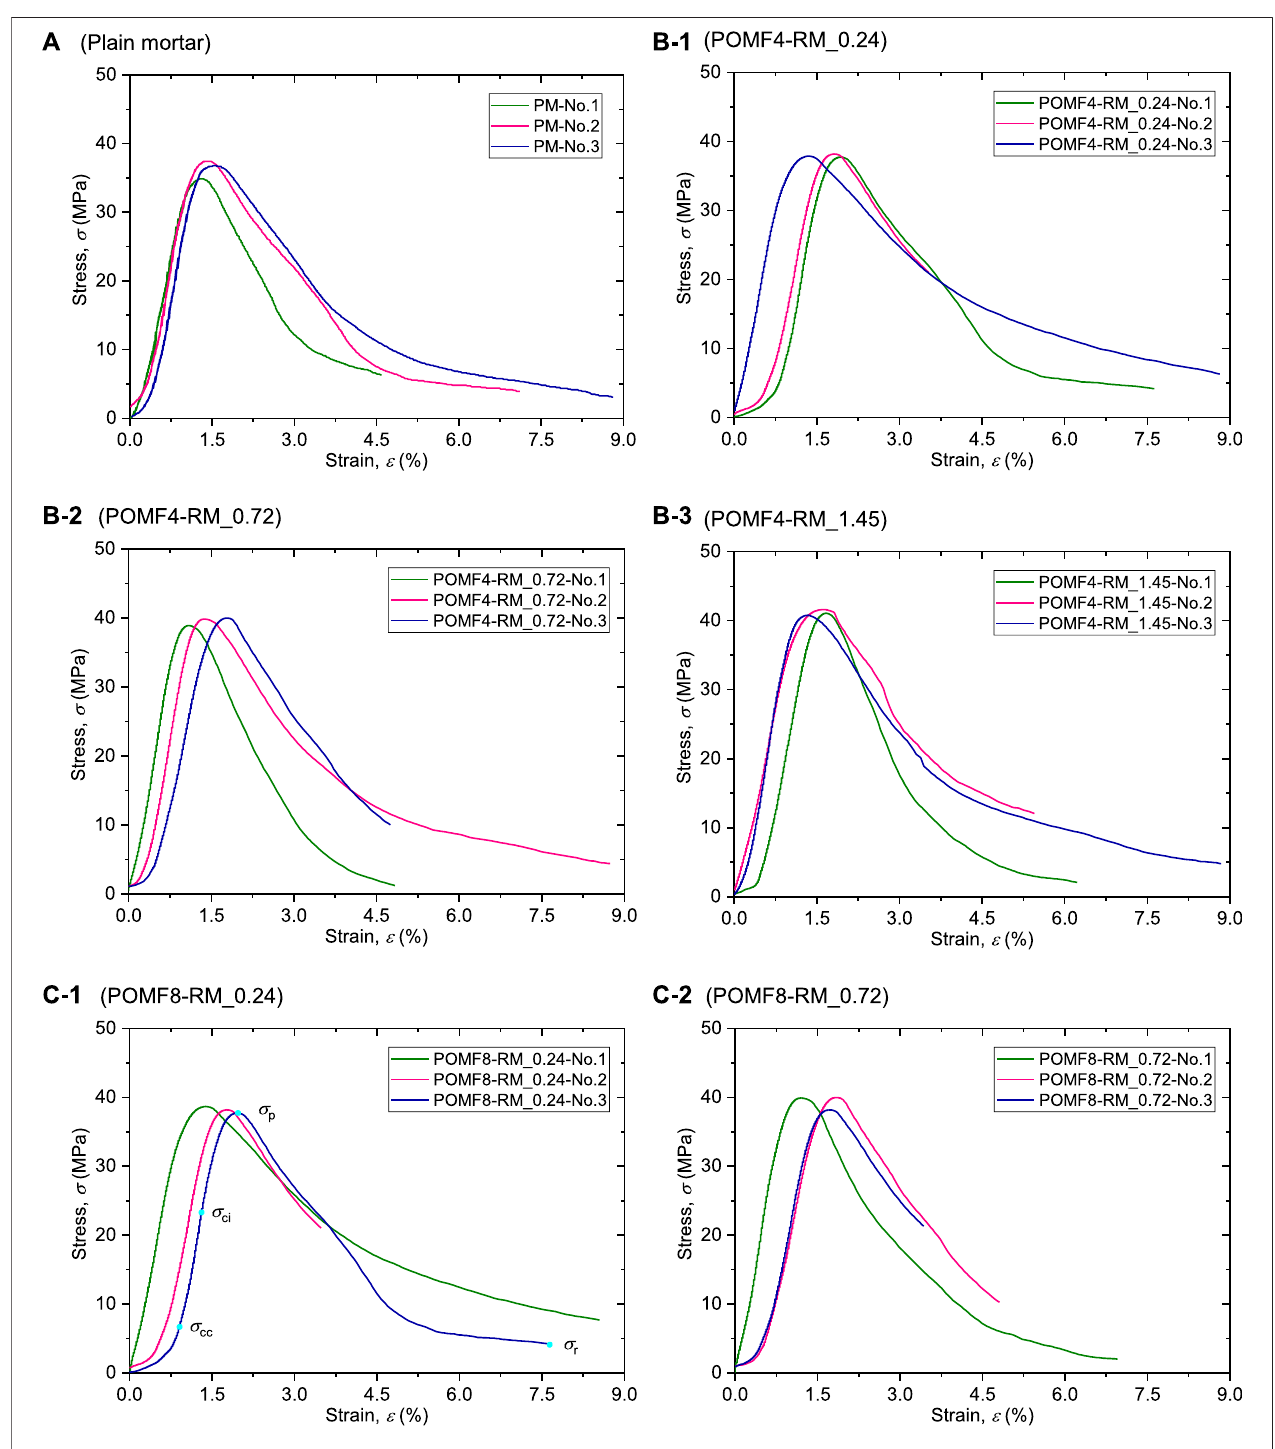
FIGURE1| Testingstress-straincurvesofthestudiedmaterials (A) ReferencegroupofPMwithoutPOMFs (B) GroupofPOMF4-RM (C) GroupofPOMF4-RM (D) Group of POMF12-RM.